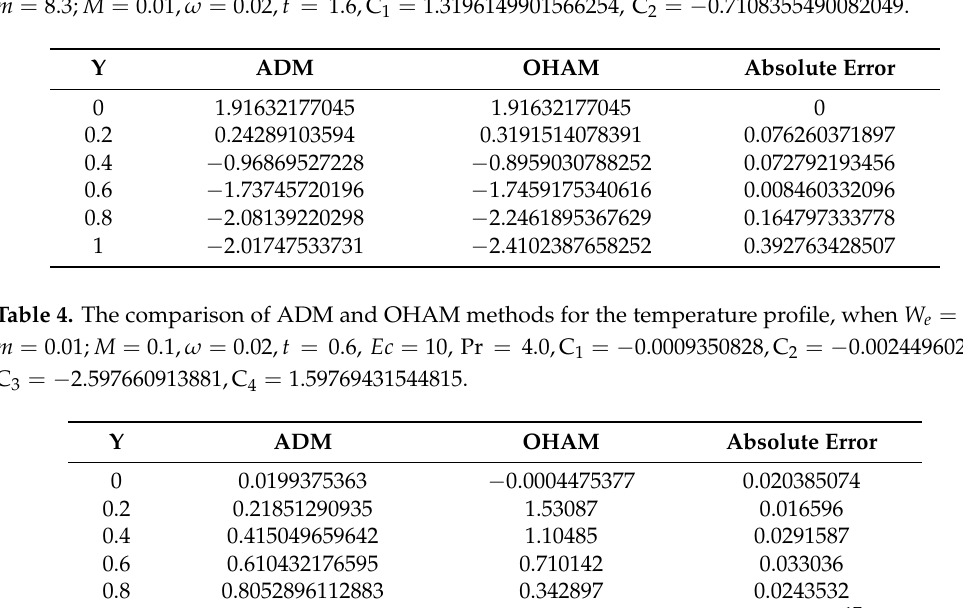
Table 3. The comparison of ADM and OHAM methods for the velocity profile, when We = 0.01, m = 8.3; M = 0.01, ω = 0.02, t = 1.6,C 1 = 1.3196149901566254, C 2 = − 0.7108355490082049.